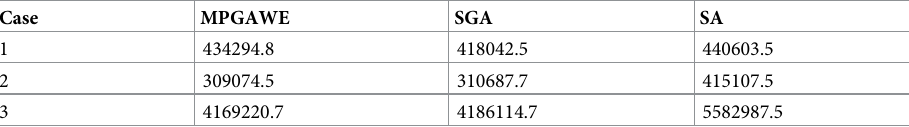
Fig 9. Results of the turning point predictions with different algorithms for the three cases. (a) Comparison of the three algorithms with the samples from Jiang’an district (case 1). (b) Comparison of the three algorithms with the samples from the Qiaokou district (case 2). (c) Comparison of the three algorithms with the samples from the Qingshan district (case 3). https://doi.org/10.1371/journal.pone.0232478.g009 Table 3. Comparison of the sum of the squared residuals (SSR) among the three